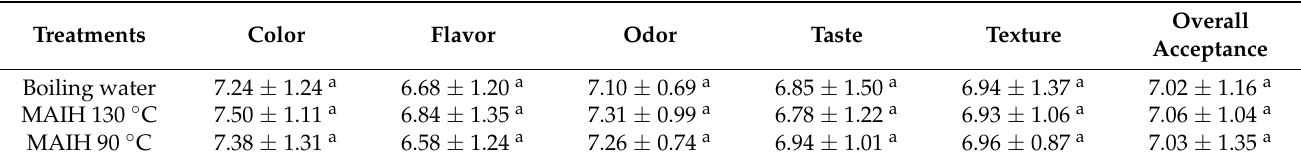
Overall Acceptance